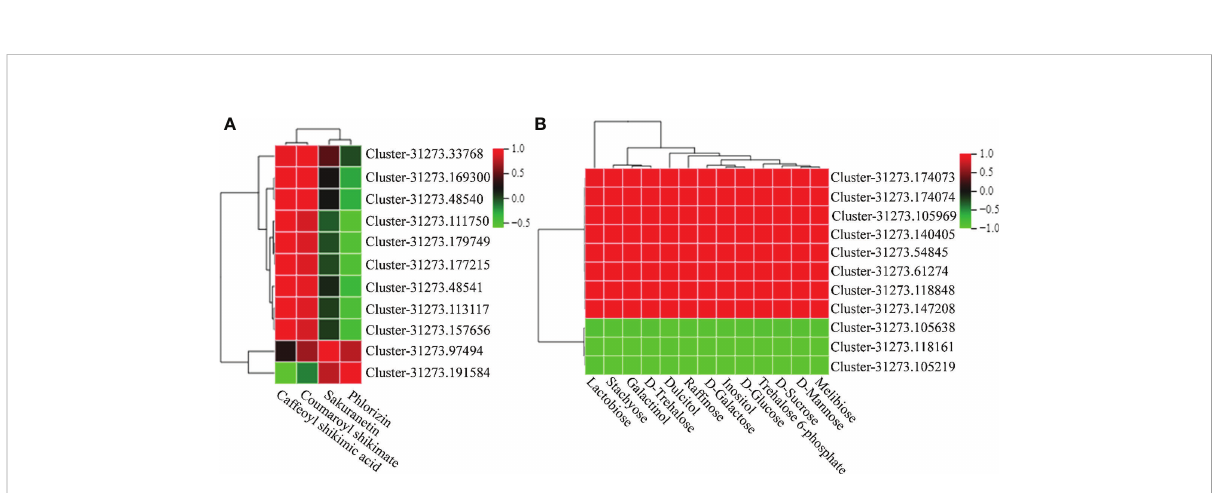
FIGURE 9 Correlation cluster heatmap of genes and metabolites. (A) Correlation cluster heatmap of DEGs or DEMs in fl avonoid biosynthetic pathways. (B) Correlation cluster heatmap of DEGs or DEMs in carbohydrate metabolism pathways. The color in the box represents the correlation of genes and metabolites (red indicates positive correlation; green indicates negative